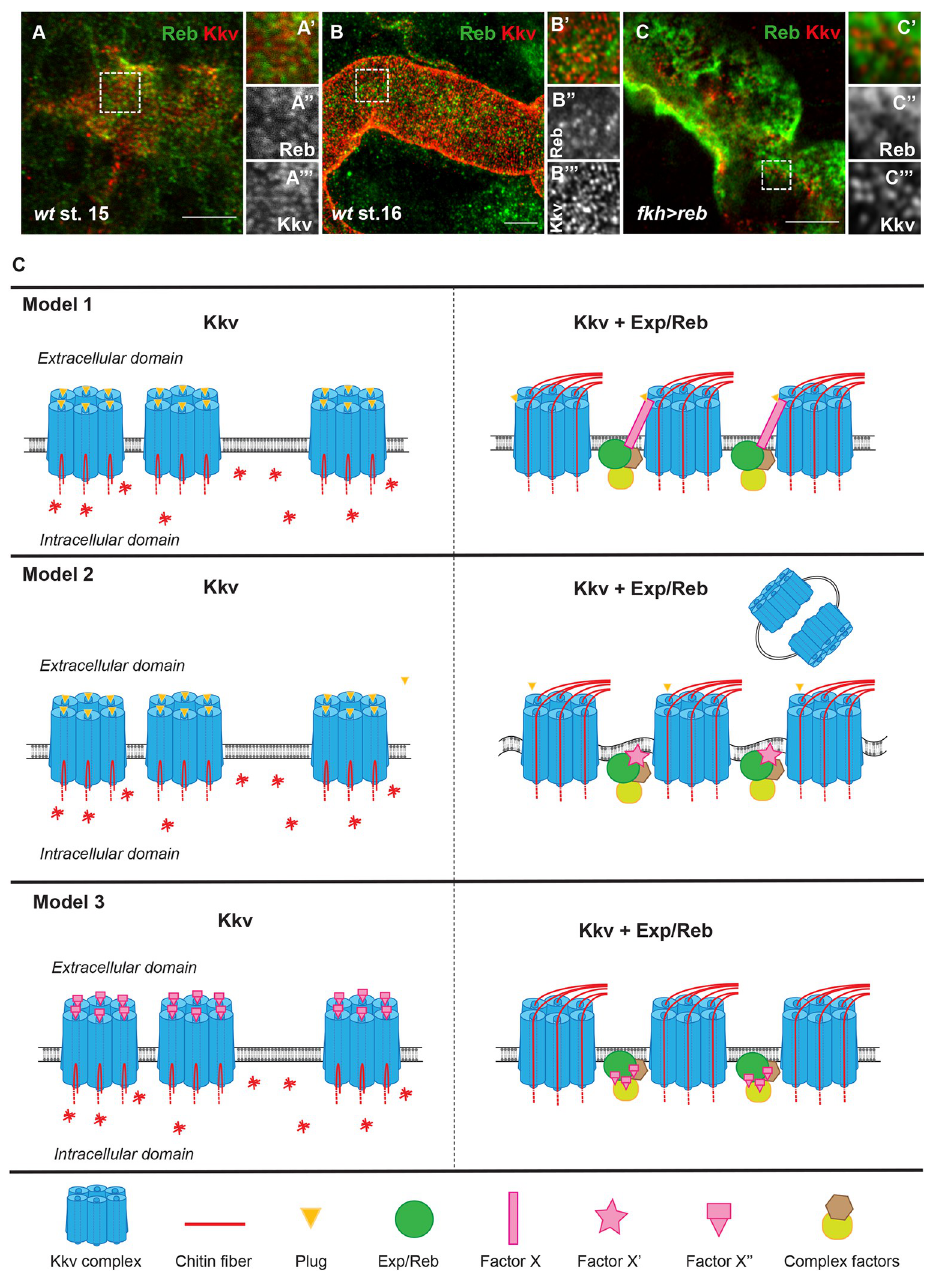
Fig 7. Accumulation of Kkv and Reb. All images are super-resolution single confocal sections except B, which is a projection of super-resolution confocal sections. ( A , B ) In the trachea of wild-type embryos, Reb and Kkv do not colocalise, and they show a complementary pattern ( A’ - A”’ ) at the local subcellular level. ( C ) In salivary gland of embryos expressing Reb, the patterns of Kkv and Reb are complementary. ( D ) Models for the role of kkv and exp/reb in chitin deposition. Kkv oligomerises in complexes that localise to the apical membrane (as proposed in [2]). In the absence of exp/reb activity, Kkv can polymerise chitin from sugar monomers (discontinuous red lines), but it cannot translocate it because the channel is closed, and polymerised chitin remains in the cytoplasm. In addition, Kkv is not homogeneously distributed. Exp/Reb form a complex with other proteins, which localises to the apical membrane. The presence of Exp/Reb complex regulates Kkv apical distribution and activity. In model 1, we propose that a factor/s recruited by Exp/Reb (Factor X) can induce a posttranslation or conformational modification to Kkv protein that opens the channel promoting translocation of chitin fibers to the extracellular domain. In model 2, we propose that a factor/s recruited by Exp/Reb (Factor X’) can induce changes in membrane composition/curvature that will then promote a conformational change in Kkv that opens the channel to translocate chitin. These membrane changes